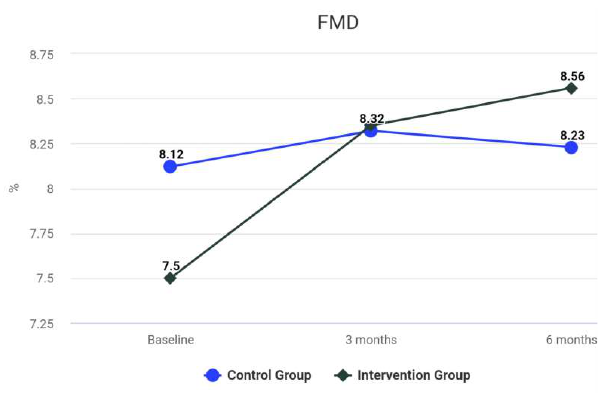
Figure 7. Results of TC at baseline and during Figure 6. Results of TC at baseline and during follow-up. Figure 6. Results of TC at baseline and during follow-up.